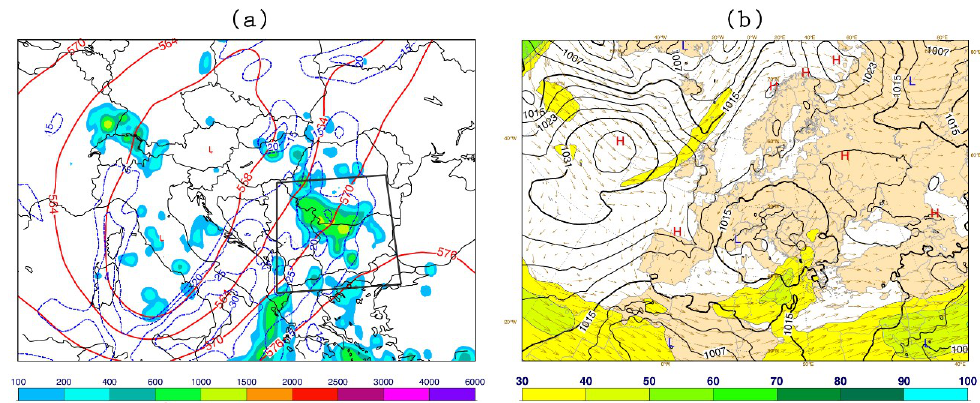
Figure 2. European Centre for Medium-Range Weather (ECMWF) analyses valid at 12 UTC on 15 May 2018 for ( a ) geopotential at 500 hPa (red lines, in dam), convective available potential energy (CAPE) (shaded, in J kg − 1 ) and 925–500 hPa wind shear (dashed blue lines, in m s − 1 ); ( b ) mean sea-level pressure (MSLP) (black lines, in hPa) and wind at 200 hPa (arrows). Wind speed above 30 m s − 1 is shaded. The black rectangle in panel ( a ) is centered over the area of